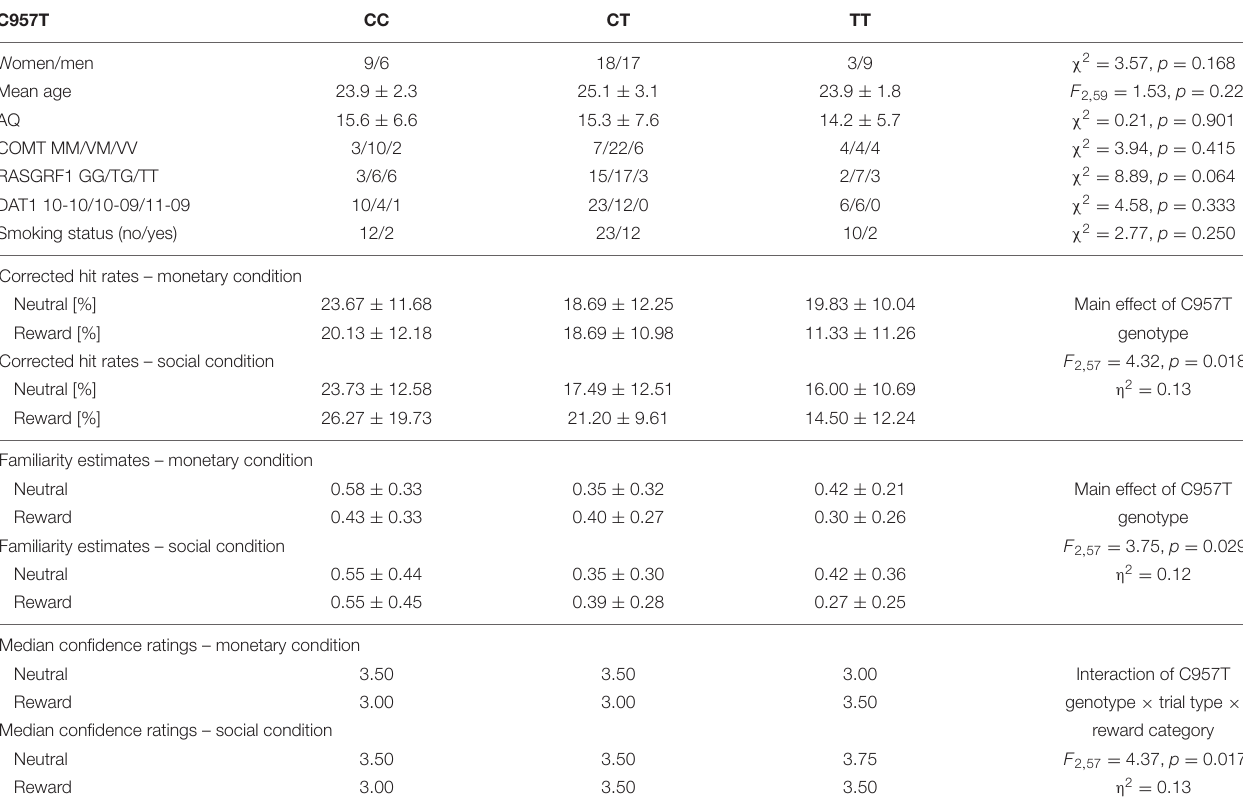
TABLE 2 | Demographic data and behavioral data of the memory parameters regarding C957T